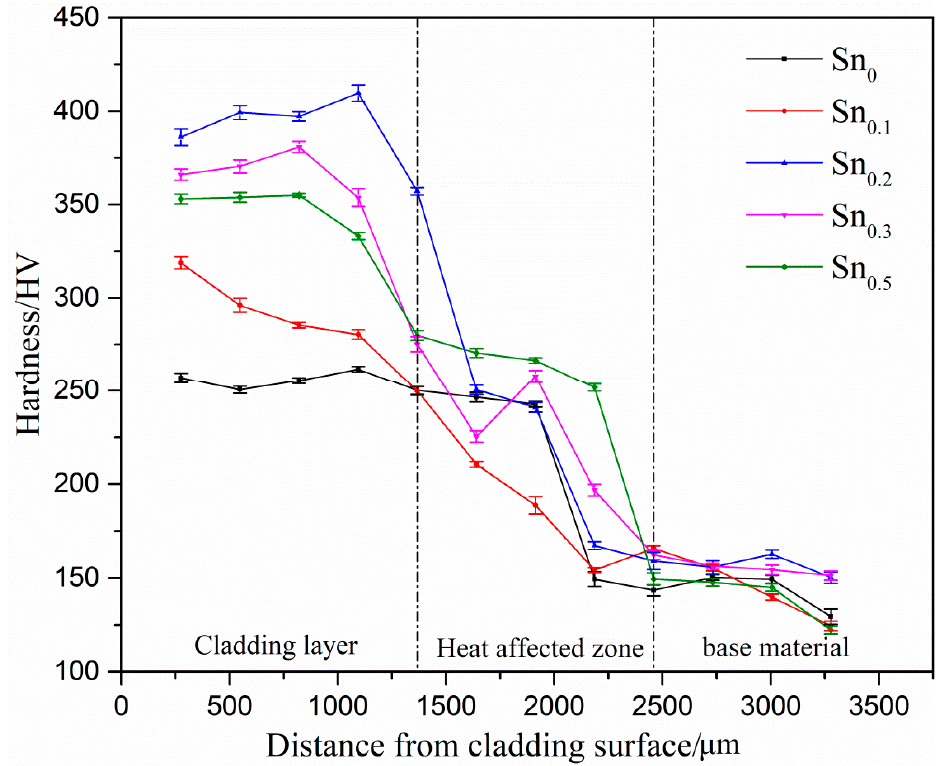
Figure 8. Cross-sectional microhardness distribution of CoCrFeNiMnSn x HEAs with different Sn Figure 8. Cross ‐ sectional microhardness distribution of CoCrFeNiMnSn x HEAs with different Sn content.